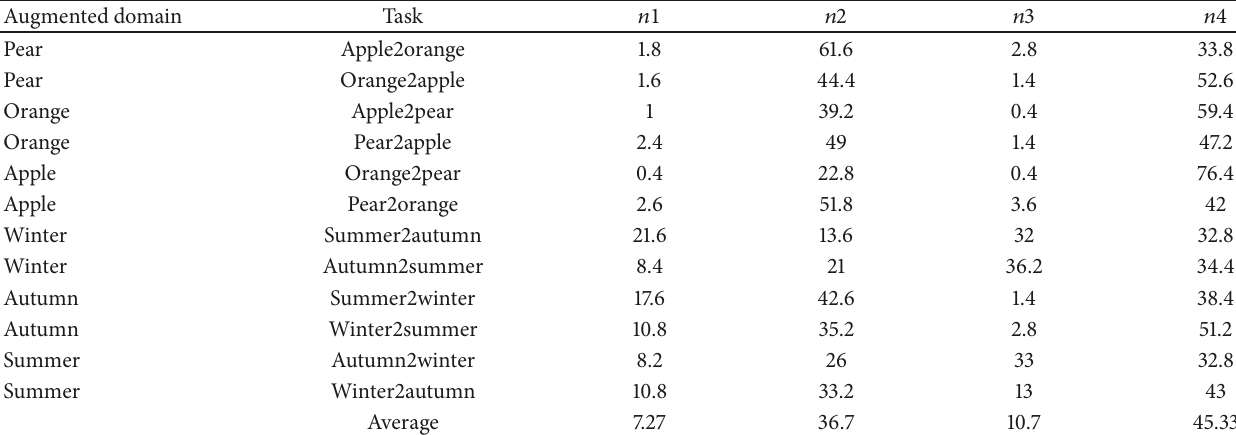
Table 5: This table shows that the results of DualGAN VS MMGANs, in which the third and the fourth column, respectively, represent a percentage of better quality of generated images by DualGAN and MMGANs. The last two columns mean the generated images by the two models generated good images and bad images in the testing sets.